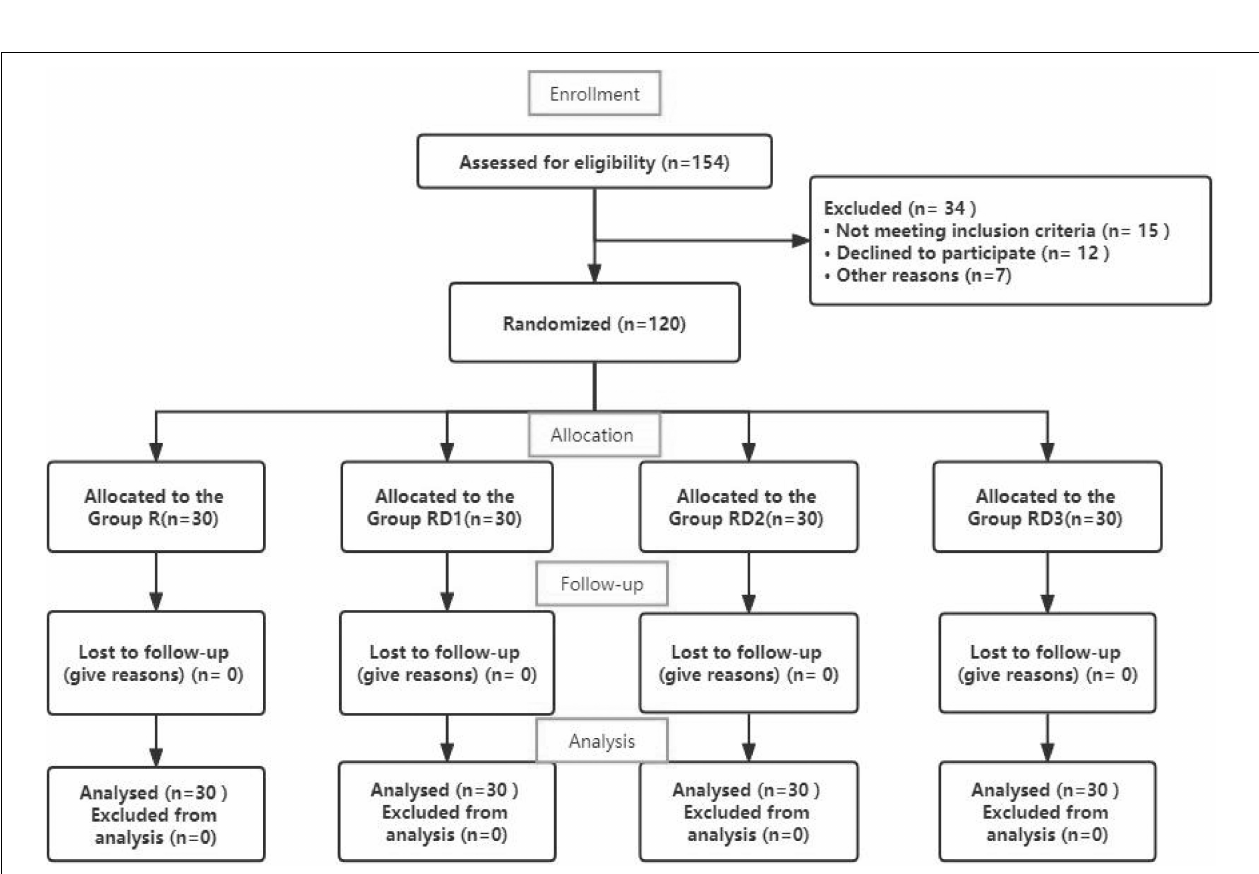
FIGURE 1 | Flow diagram of study.